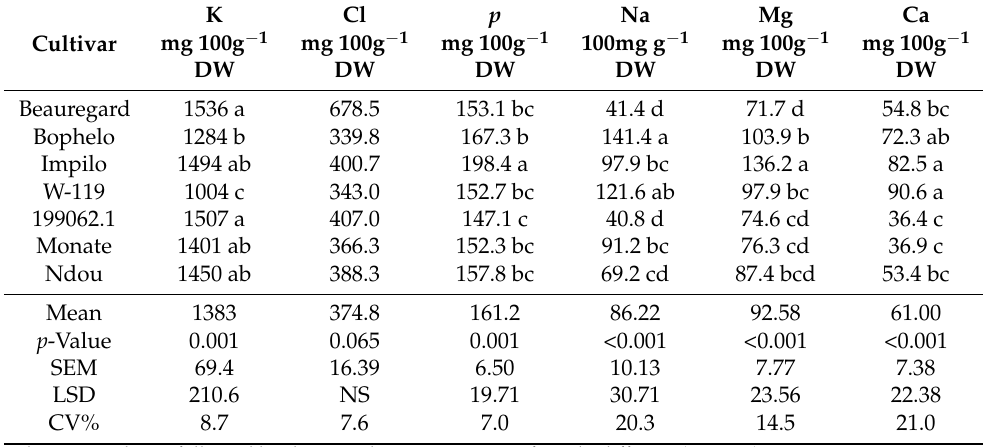
Table 4. Content of macro-elements of sweet potato cultivars with varying flesh colors.